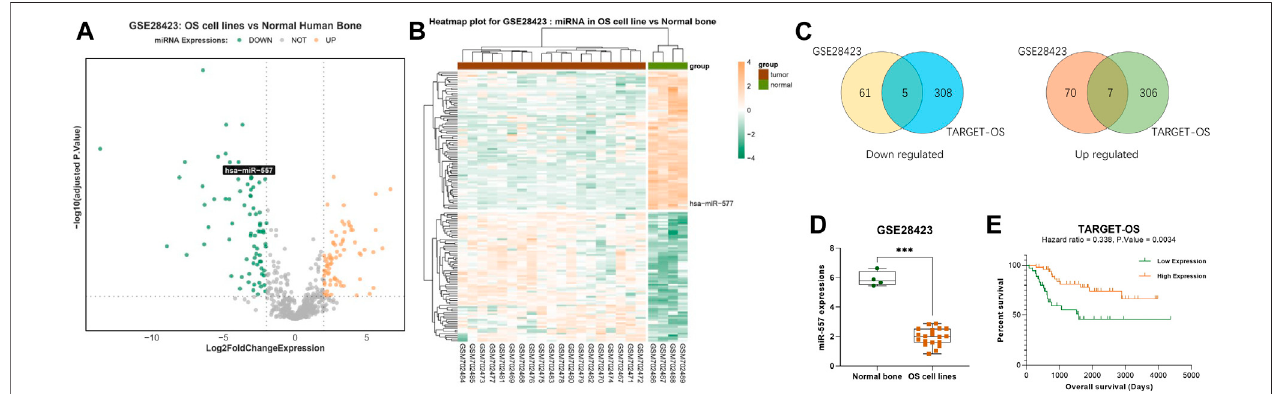
FIGURE 1 | Hsa-miR-557 positively correlate with the survival rate of osteosarcoma patients: (A,B) GSE28425 dataset from the GEO showed 74 upregulated miRNAs (log 2 foldchange > 2, adjusted p . value < 0.05) and 79 downregulated miRNAs (log 2 foldchange < -2, adjusted p . value < 0.05). (C) Combining data from GSE28425 with 89 OS patient samples from TARGET, 7 miRNAs were downregulated in the GSE28425 dataset and lowly expressed in the TARGET database (hsa- miR-140-3p,hsa-miR-564,hsa-miR-765,hsa-miR-1224-5p,hsa-miR-95,hsa-miR-940,andhsa-miR-557),and5miRNAs(hsa-miR-362-3p,hsa-miR-149,hsa- miR-96, hsa-miR-744, and hsa-miR-769-5p) were upregulated in the GSE28425 dataset and highly expressed in the TARGET database. (D) Signi fi cant low levels of hsa-miR-557 were found in osteosarcoma cell lines from GSE28425. (E) Data from TARGET-OS showed that hsa-miR-557 positively correlate with the survival rate of osteosarcoma patients (hazard ratio < 1, p . value <